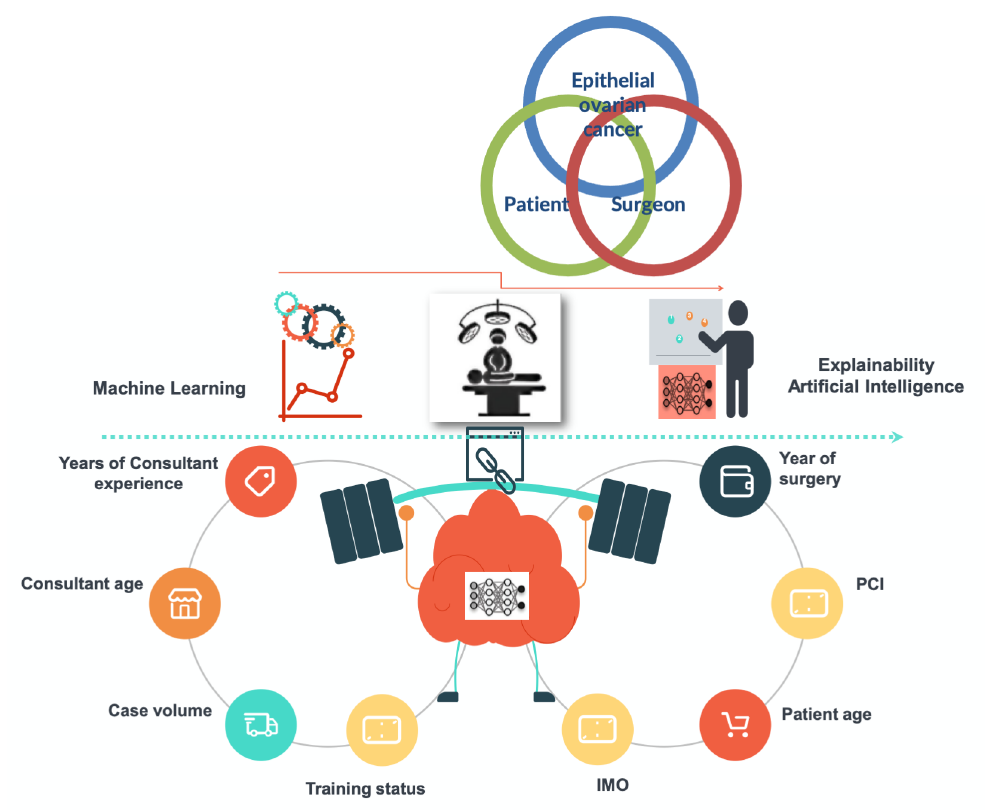
Figure 8. Schematic representation of our concept, exploring features affecting surgical effort at cytoreductive surgery for EOC. Explainable AI is employed to interpret the fine balance between factual knowledge and surgical